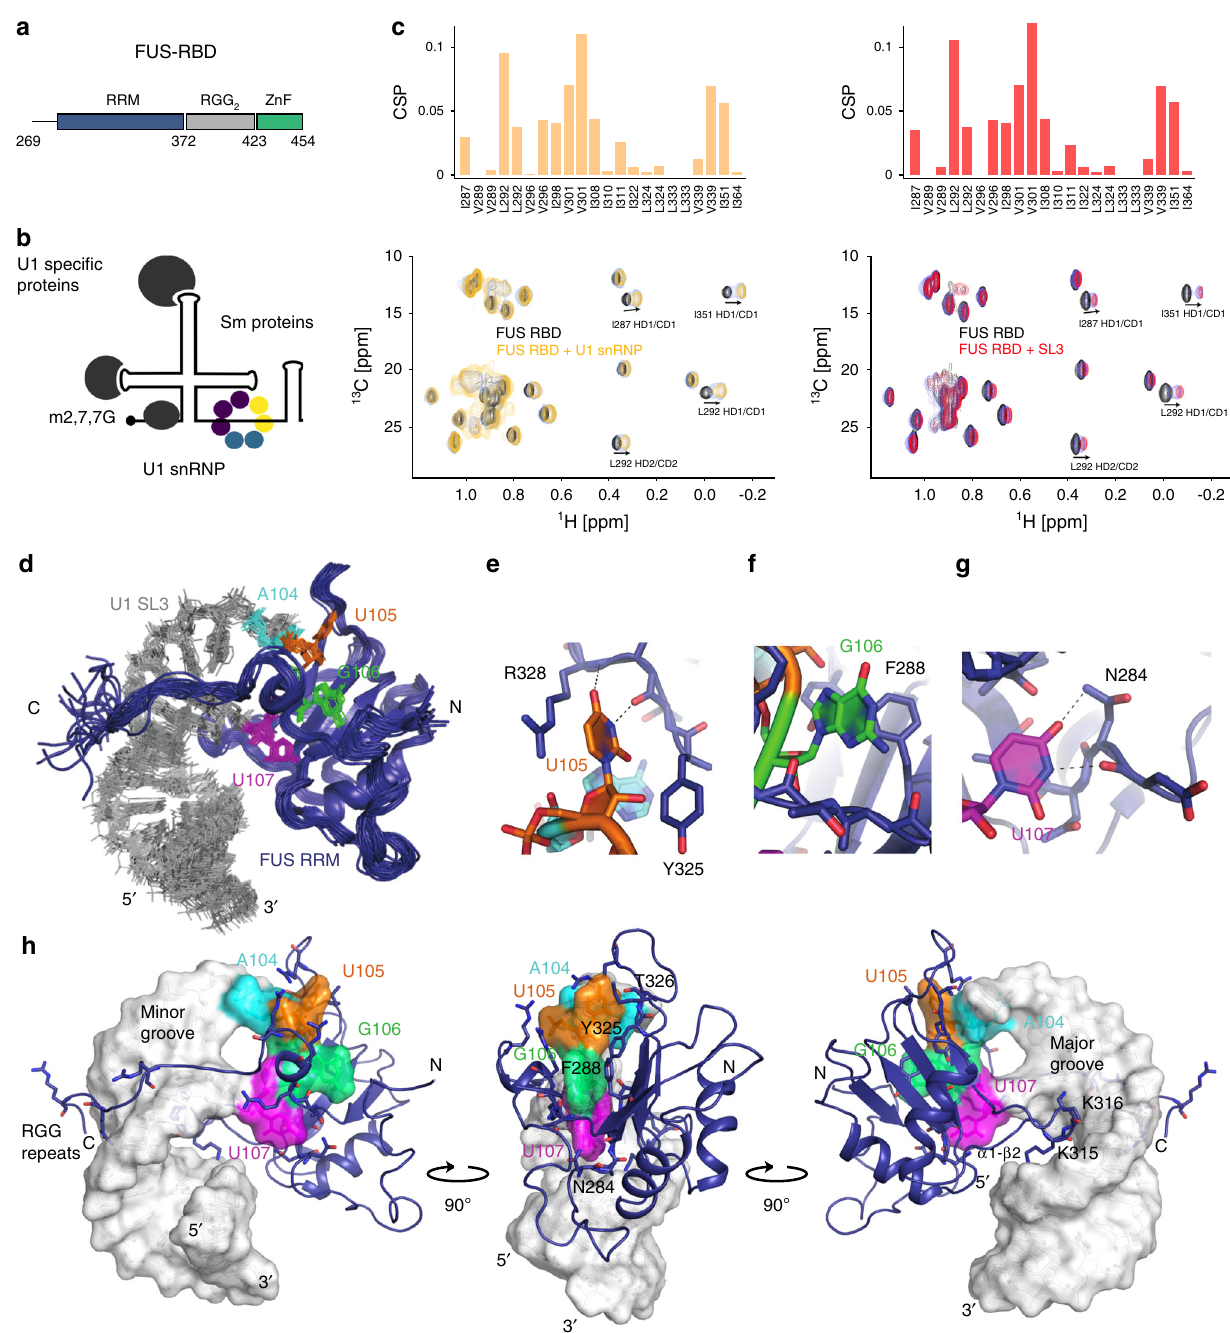
Fig. 3 Structural basis of the FUS – U1 snRNP interaction. a Schematic representation of the FUS RBD. b Scheme of U1 snRNP. c Plot showing the chemical shift perturbations experienced by ILV methyl groups of FUS RBD upon addition of U1 snRNP (orange) or U1 SL3 (red). Below each graph, an overlay of the 2D 13 C- 1 H HMQC spectra of the free and bound FUS – RBD is shown. n = 3. d Ribbon representation of the solution structure of FUS RRM aa 260 – 390 (blue) bound to U1 SL3 (grey). e Close-up view on U105-speci fi c recognition. f Close-up view on G106-speci fi c recognition. g Close-up view on U107- speci fi c recognition. h Lowest energy model of the NMR ensemble. The surface of the RNA is depicted in grey, while the FUS RRM is shown as a ribbon and coloured in